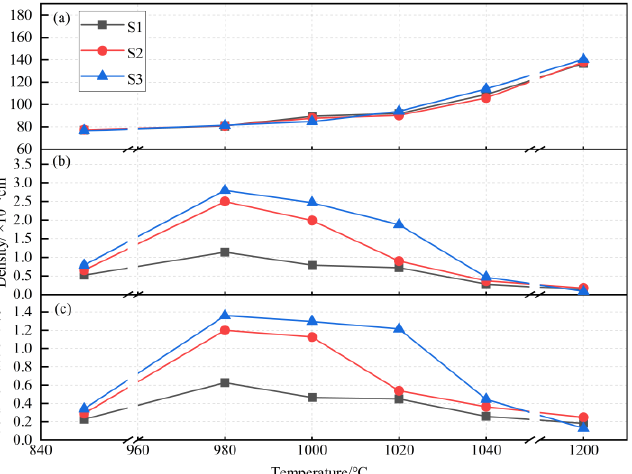
Figure 6. Statistics of precipitates in the extracted samples during high temperature annealing. ( a ) average diameter; ( b ) distribution density; ( c ) volume fraction. From 1000 ◦ C, the volume fractions of precipitates in the three samples all began